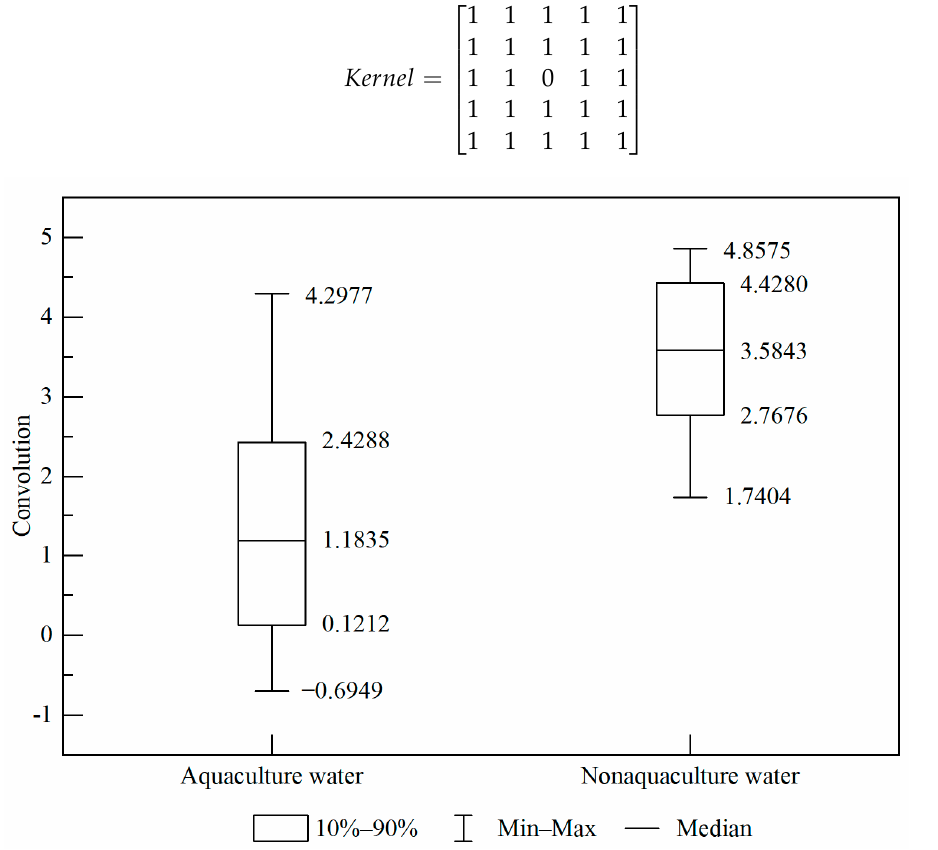
Figure 8. Comparison of MNDWI convolution values of aquaculture and non-aquaculture water bodies in the study area.